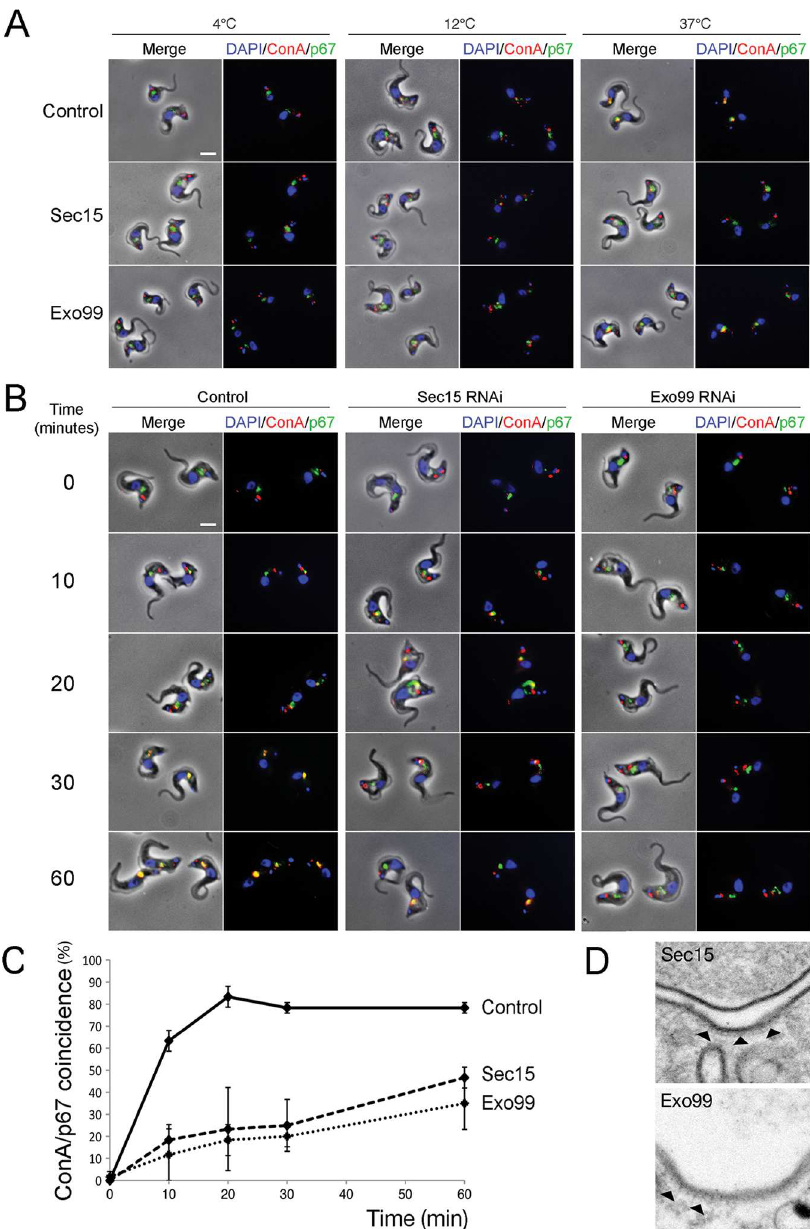
Fig 5. The exocyst is required for endocytosis. (A) Uninducedand inducedSec15 and Exo99::RNAicells were allowedto accumulate FITC-conjugated ConA at the indicatedtemperatures. Fixed cells counterstained with DAPI (blue) and anti-p67antibody for the lysosome(green). Both Sec15 and Exo99::RNAi lines show a defect in delivery of ConA to the lysosome: at 12˚C and 37˚C ConA remainspredominantlylocalisedat the flagellar pocket. (B) Dynamics of ConA uptake at 37˚C 48h post RNAi induction.In control cells, ConA accumulates in a p67-positive compartment within 30 min. By contrast Sec15 and Exo99::RNAi cells exhibit a marked delay in delivery of ConA to the lysosome. In all images DAPI was used to visualiseDNA (blue). Scale bar, 5 μ m. (C) Quantitationof ConA lysosomal delivery at 37˚C 48h post induction.N = 25 cells per time point per duplicateexperiment. (D) Representative electron micrograph of curved flagellar pocket membrane coated by clathrin. Arrowheadspoint at clathrin coat.